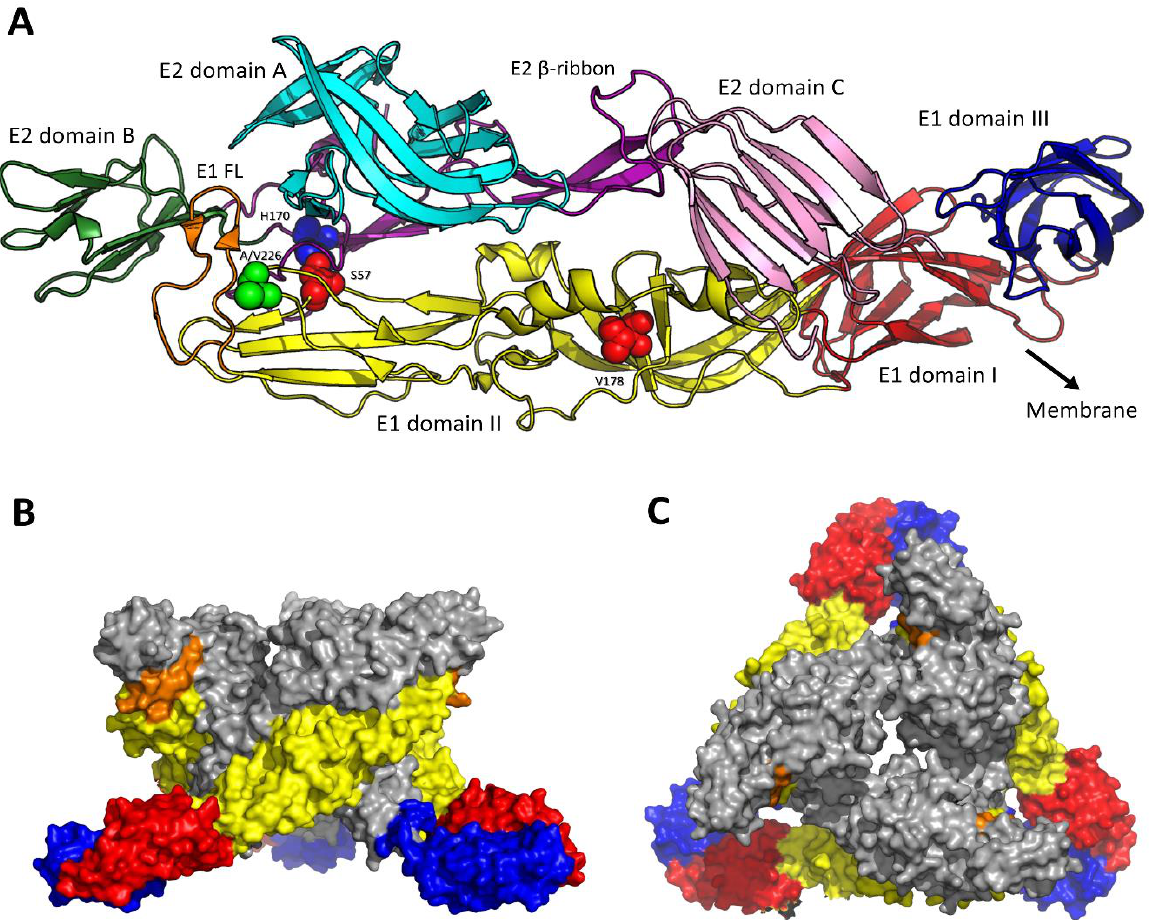
Figure 1. Structure of the E2/E1 dimer. ( A ) Ribbon diagram showing the ectodomains of the CHIKV E1 and E2 glycoprotein ([22]; PDB 3N41). The structural domains I, II, and III of E1 are shown in blue, red and yellow, respectively. E2 domain A, B, and C are designated in cyan, green, and pink, respectively. In the mature virion, the E1 fusion loop (E1-FL, orange), is covered by a binding groove between E2 domain A and B. The β -ribbon of E2 containing the acid-sensitive region is highlighted in dark purple. Within this region, the hydrogen bond between E2-H170 and E1-S57 stabilizes the E2/E1 dimer interaction at neutral pH [26,142]. E1-A/V226 and E1-V178 are important for lipid sensing before fusion [12,154]. The black arrow points towards the viral membrane; ( B , C ) Surface view (PDB 2XFC) of one virus spike from the side ( B ) and the top ( C ). E1 is depicted in the same colors as in the ribbon diagram, E2 is depicted in gray for clarity. This figure was prepared using the program PyMOL.